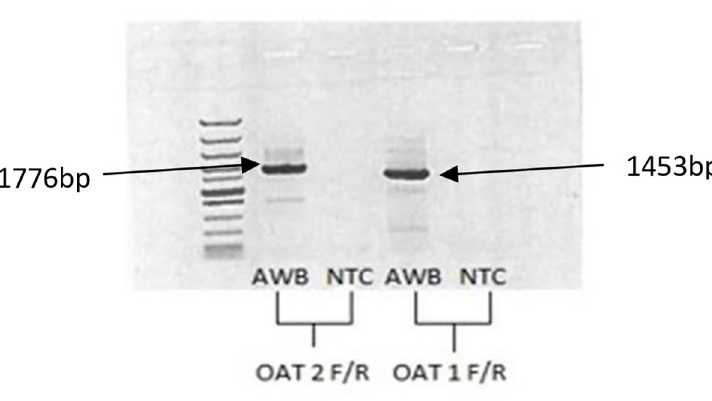
Fig 1. Conventional PCR amplified OAT1 and OAT2 gene from AWB vulture‘s kidney, no product was obtained when the template was omitted, molecular size (100bp) is indicated on the left. NTC = no template control.